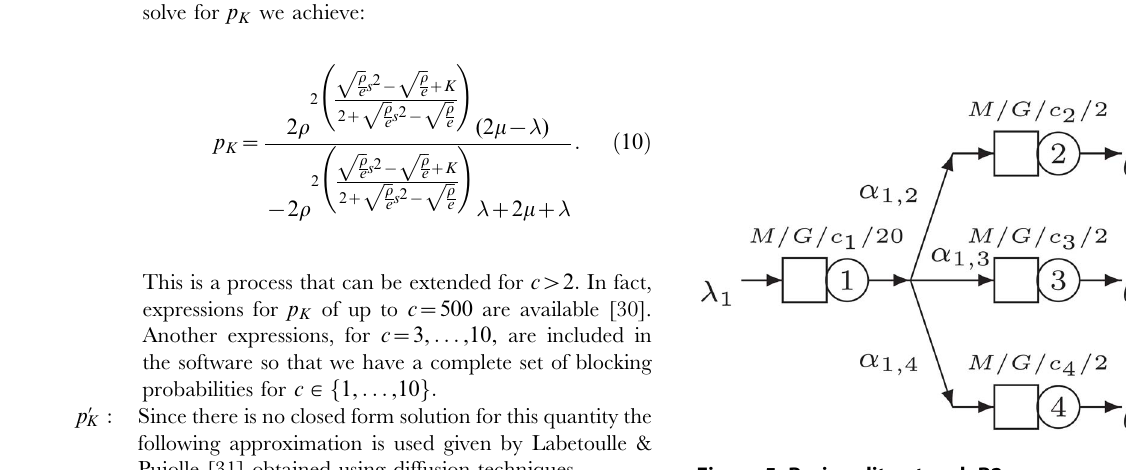
Figure 5. Basic split network B2.